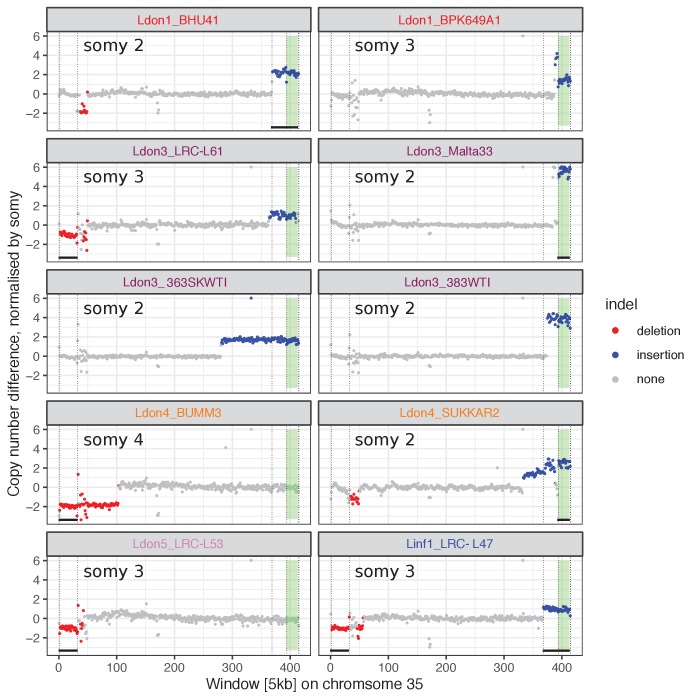
Most chromosome scale CNVs are located on chromosome 35.Shown are genome coverages of chromosome 35 for all samples that harbour at least one chromosome-scale CNV (>100 kb). Genome coverage for 5 kb windows was normalised by the sample and chromosome specific somy and coloured in red and blue for duplications and deletions, respectively. The respective chromosome-specific somy is indicated in each plot. Vertical lines mark indel boundaries and horizontal black bars below indicate indels with shared identical boundaries between samples. The green rectangles mark the CD1/LD1 locus sequences for L. infantum described in Sunkin et al. (2001). Group origin of the different samples is indicated by the group colours used throughout this study.